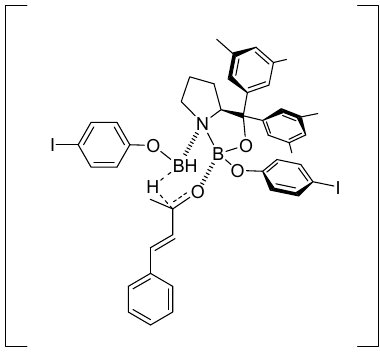
Figure 4. Proposed transition state model.